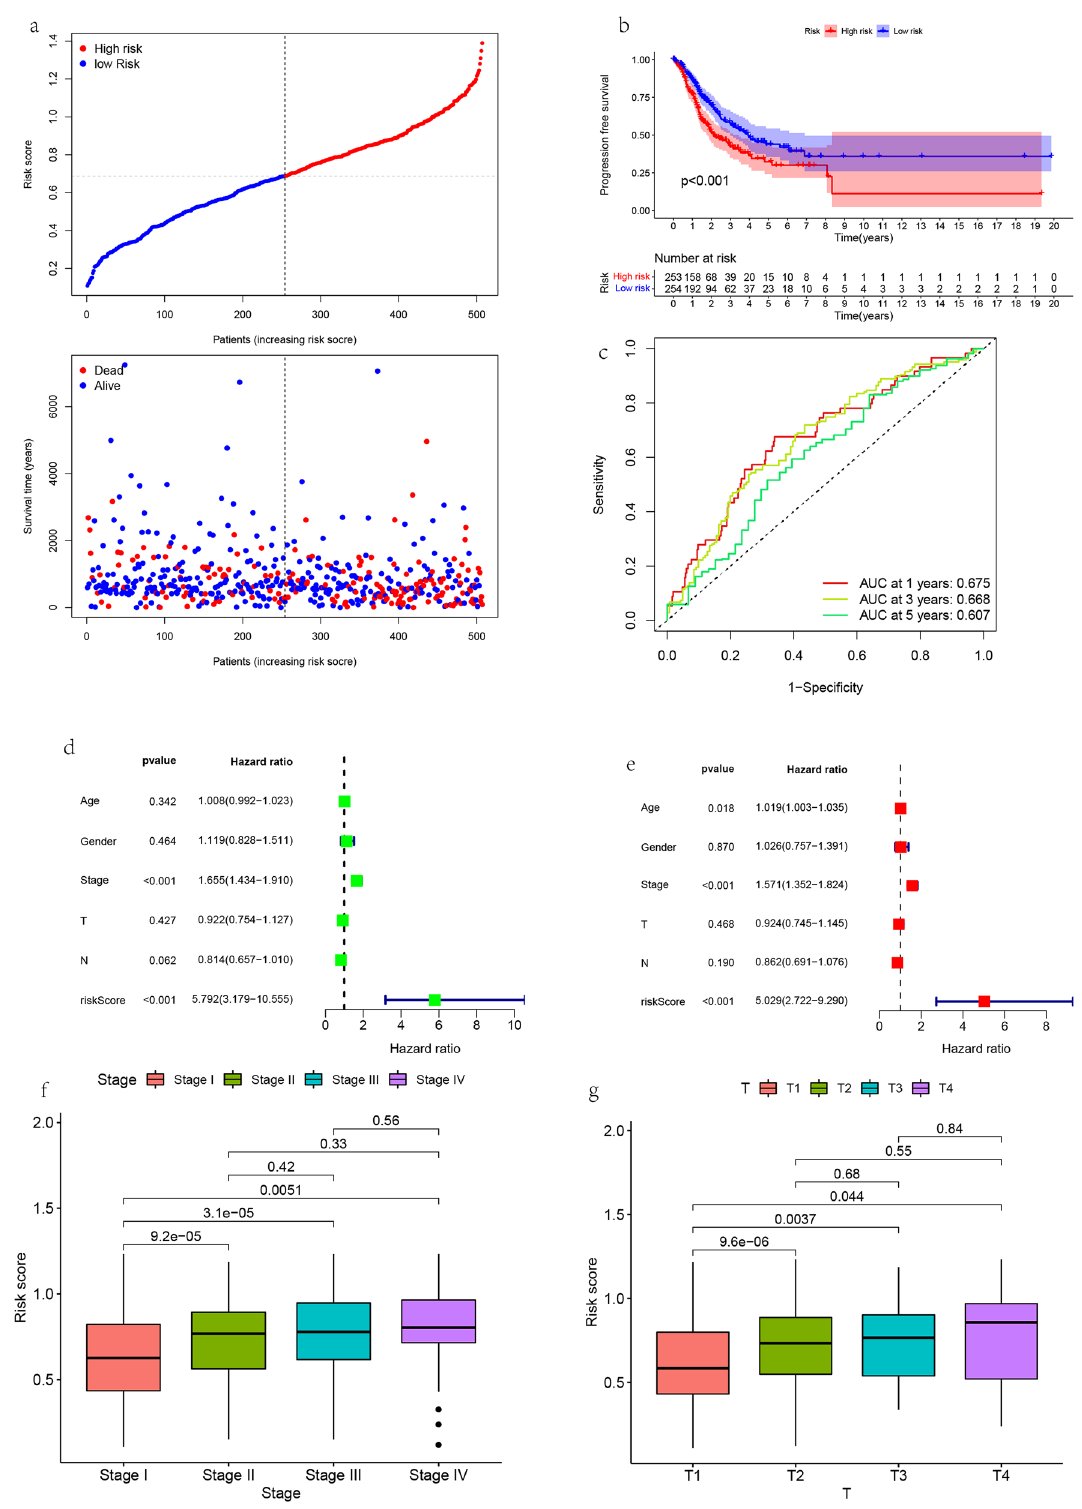
Figure 6. Clinical correlation analysis of prognosis model. ( a ) Risk score distribution and survival status of each patient. ( b ) Progression free survival. ( c ) Receiver operating characteristic (ROC) curve shows the prediction efficiency of risk score. ( d ) Univariate Cox regression analysis in TCGA cohort. ( e ) Multivariate Cox regression analysis in The Cancer Genome Atlas (TCGA) cohort. ( f ), ( g ) Relationship between clinical stages and risk